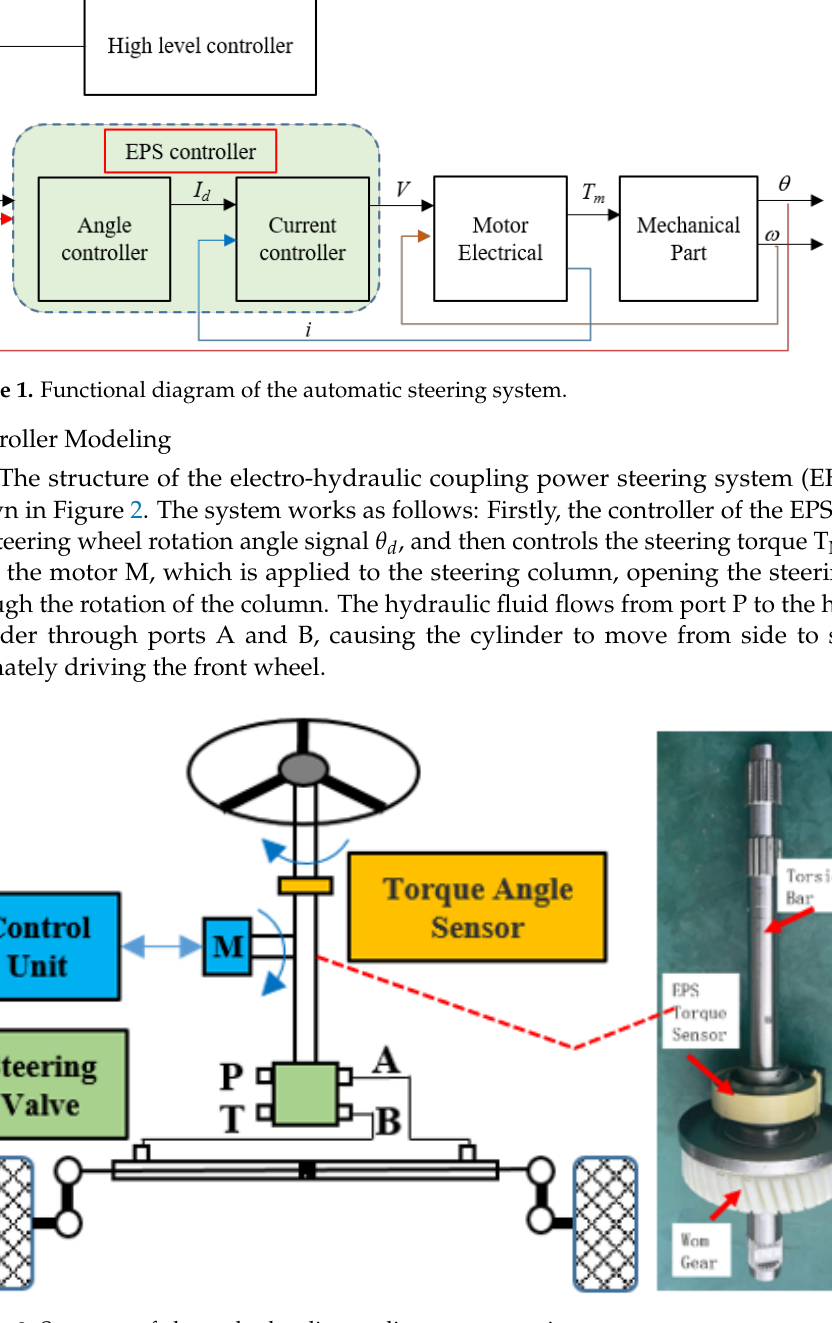
Figure 2. Structure of electro-hydraulic coupling power steering system.